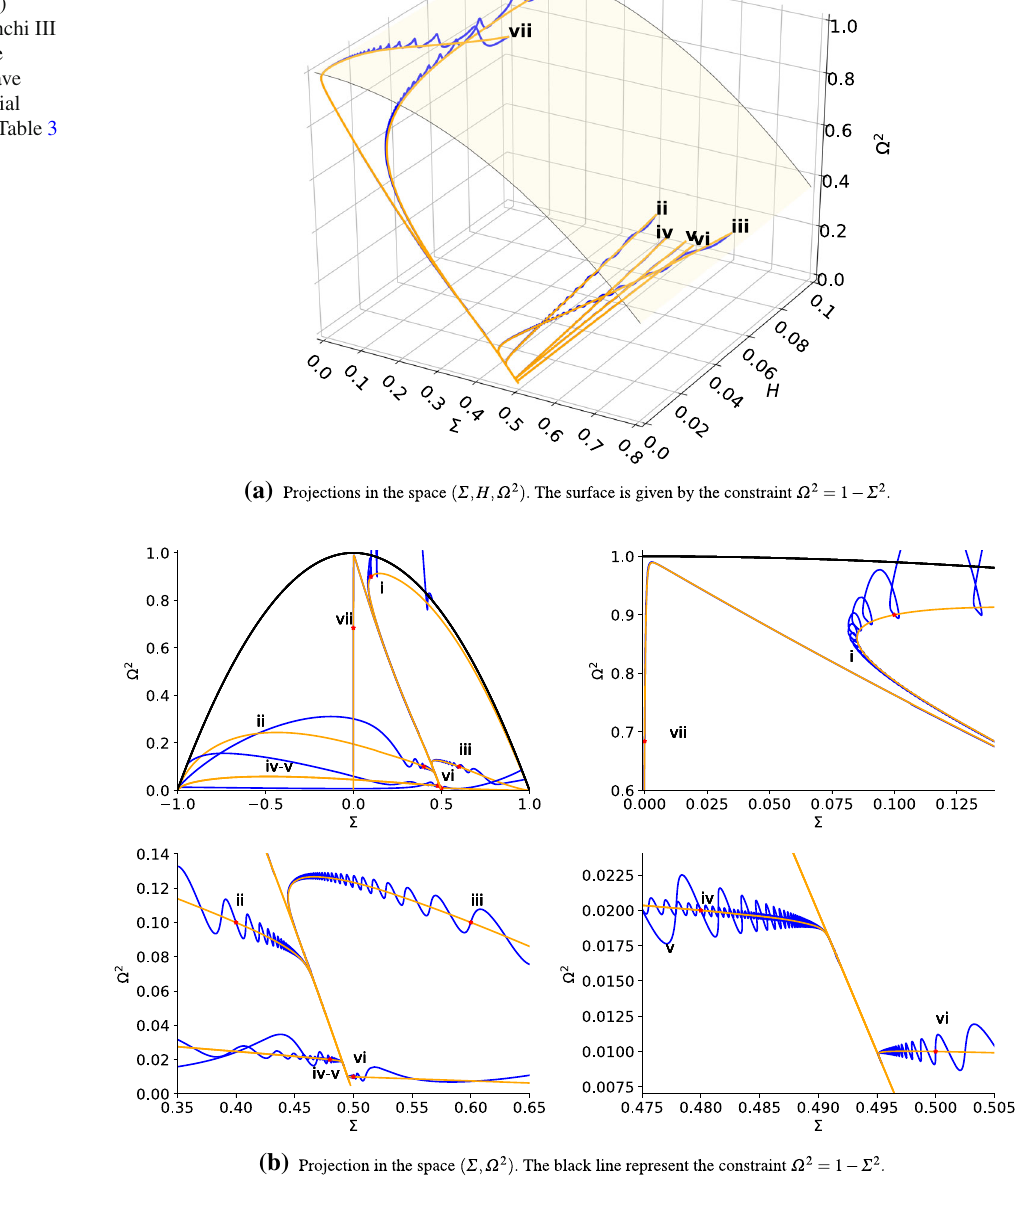
Fig. 19 Some solutions of the full system (46) (blue) and time-averaged system (78) (orange) for the LRS Bianchi III metric when γ = 2, in the projection Ω k = 0. We have used for both systems initial data sets presented in the Table